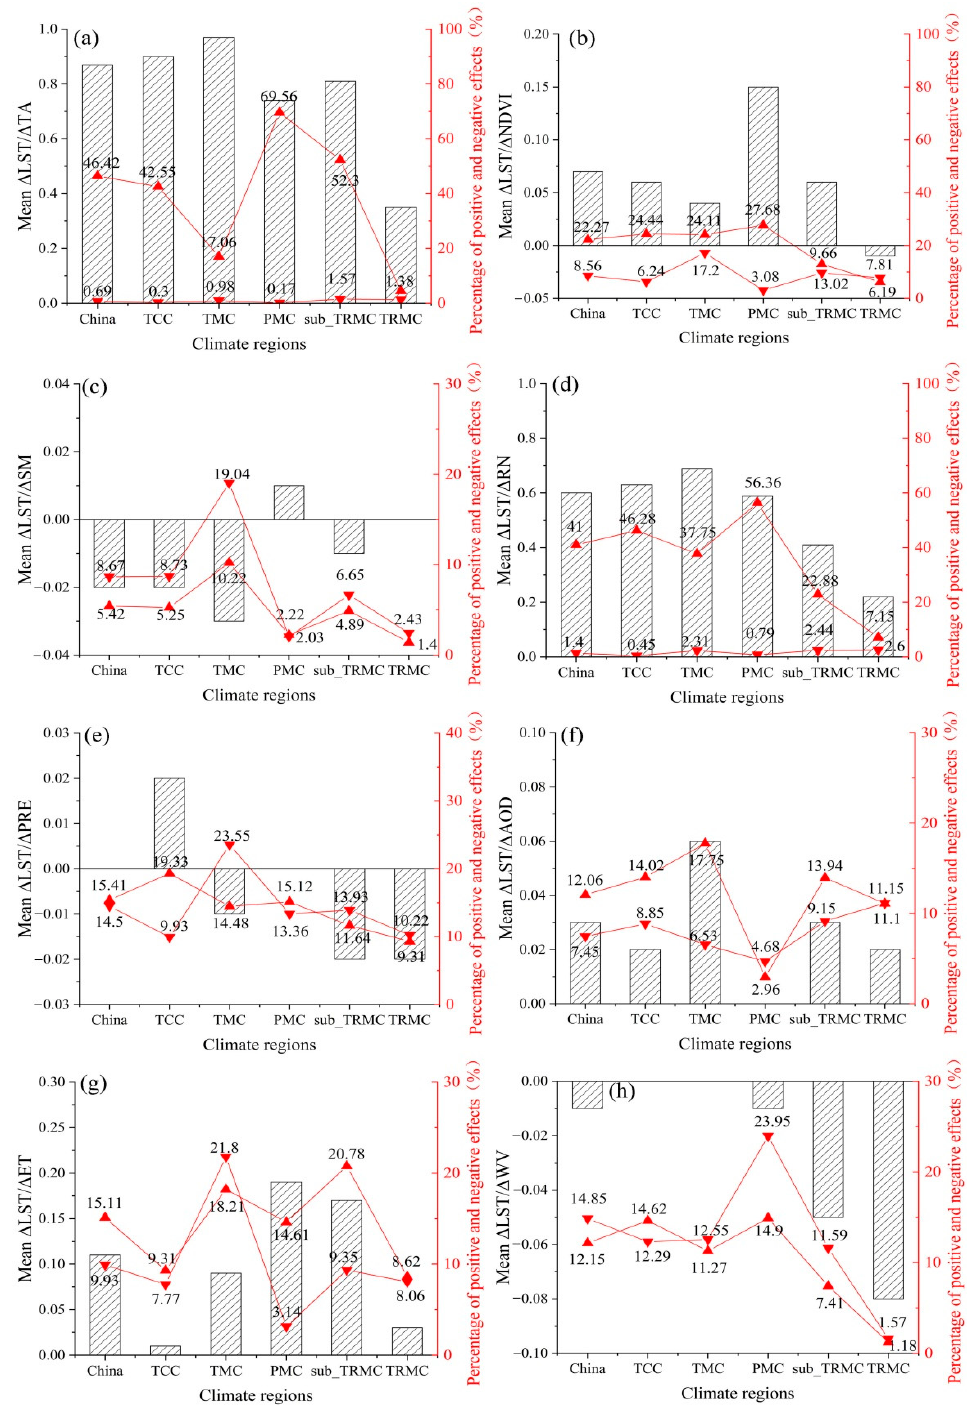
Figure 14. Statistical results of the strength of the driver effect on LST in different climate zones. ( a ) the strength of the effect of each driver on LST within different climate zones, the red upper triangles indicate the proportion of positive effects, and the lower triangles indicate the proportion of negative effects.